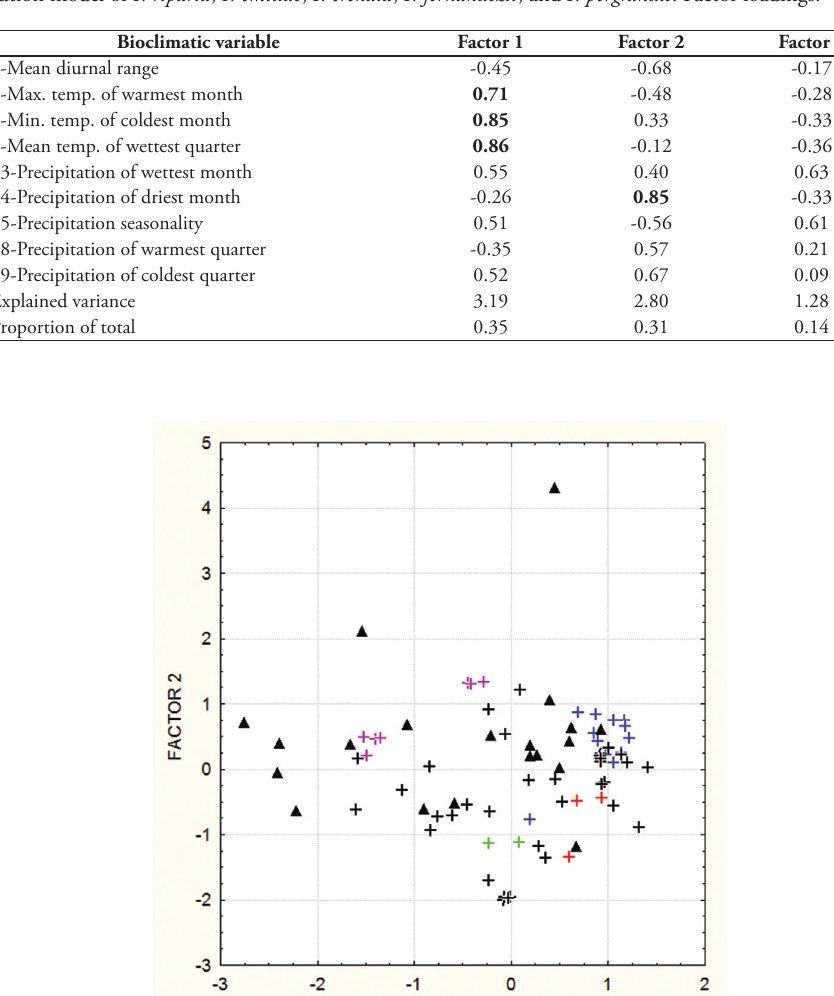
Table 4. Principal component analysis on the bioclimatic variables contributing to the MAXENT distri- bution model of P. riparia , P. emiliae , P. crenata , P. fernandezii , and P. pergrandis . Factor loadings.